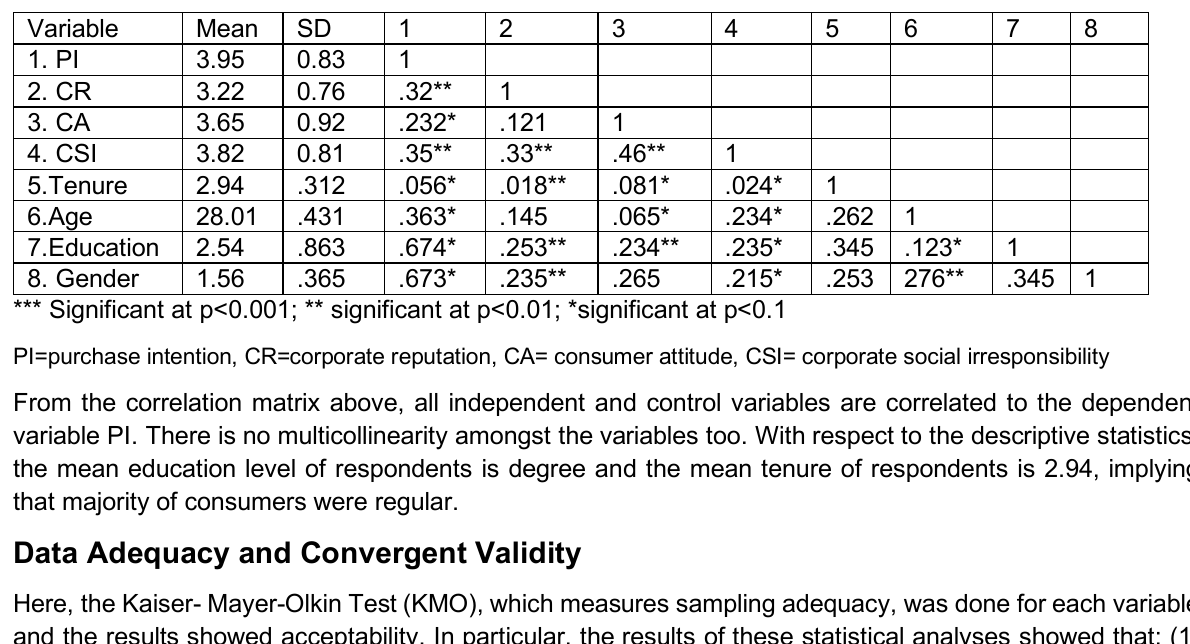
Table 1: Descriptive statistics and correlation